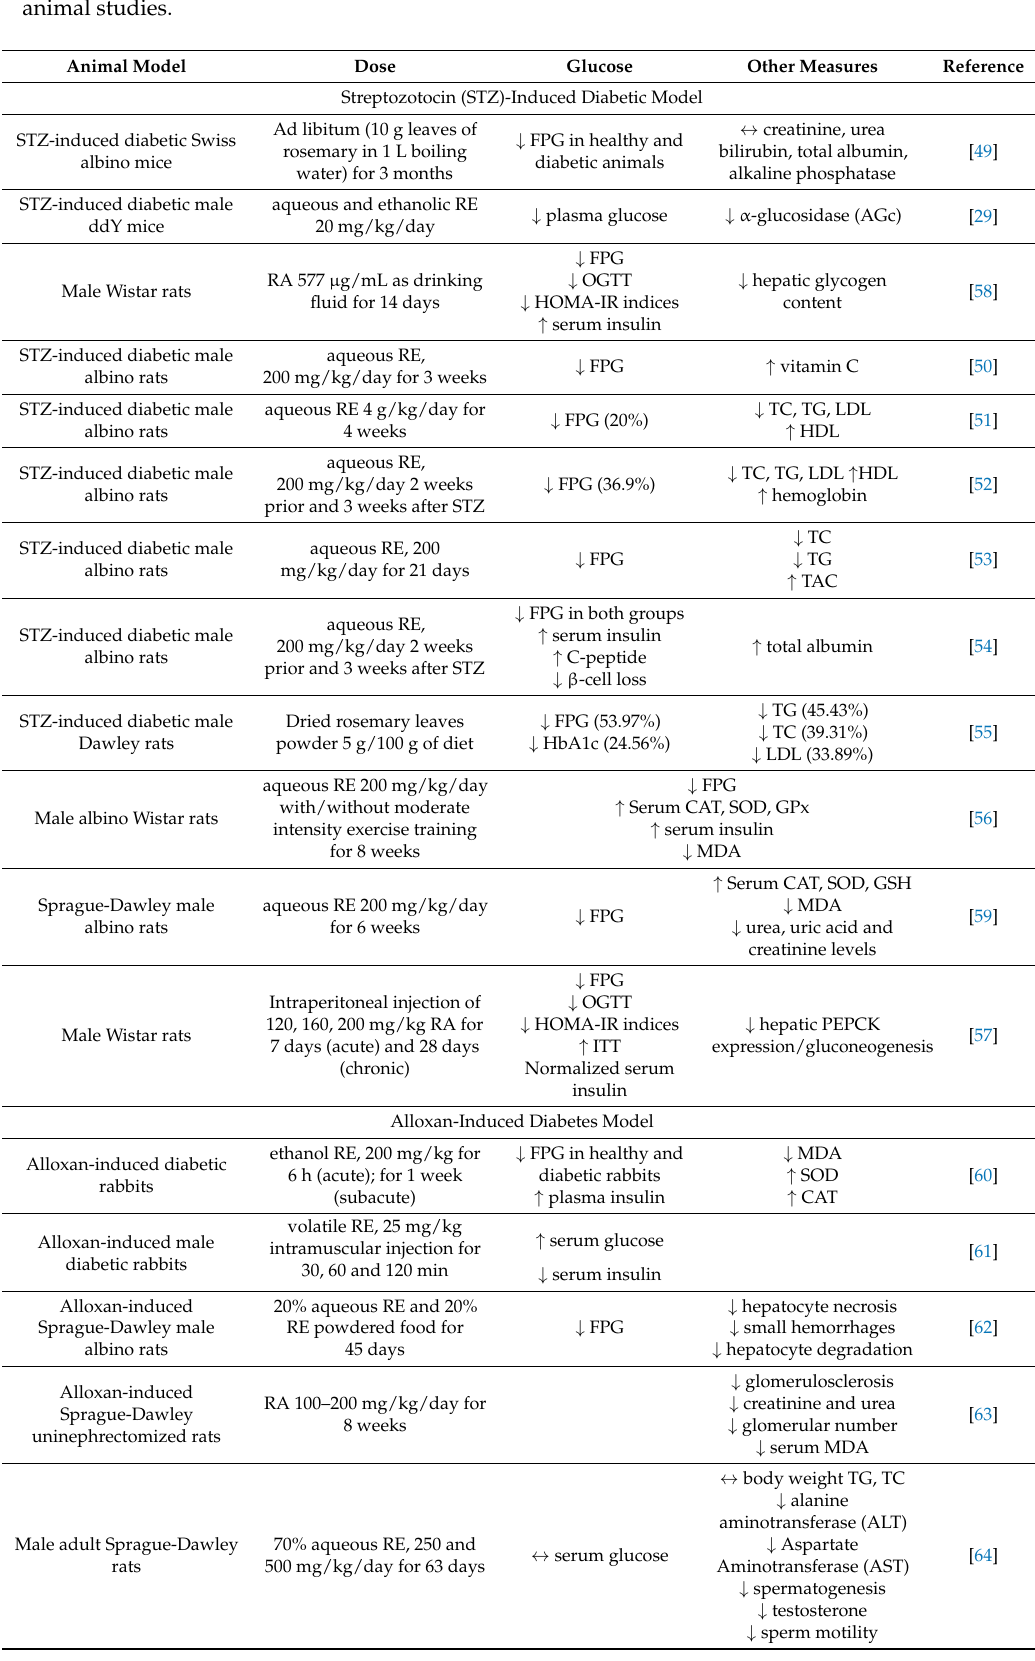
Table 6. Anti-diabetic Effects of Rosemary Extract and its Main Polyphenolic Constituents: in vivo animal